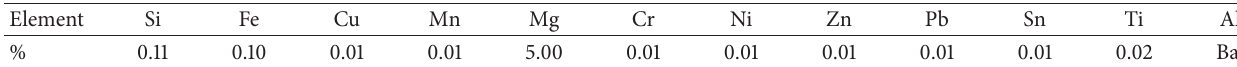
Figure 1: The formation of a double oxide film defect. (a) Surface turbulence leads to a breaking wave on the metal surface, and (b) the two unwetted sides of the oxide films come into contact with each other as the bifilm is entrained into the bulk liquid metal [4]. Table 1: Chemical composition of the alloy used.